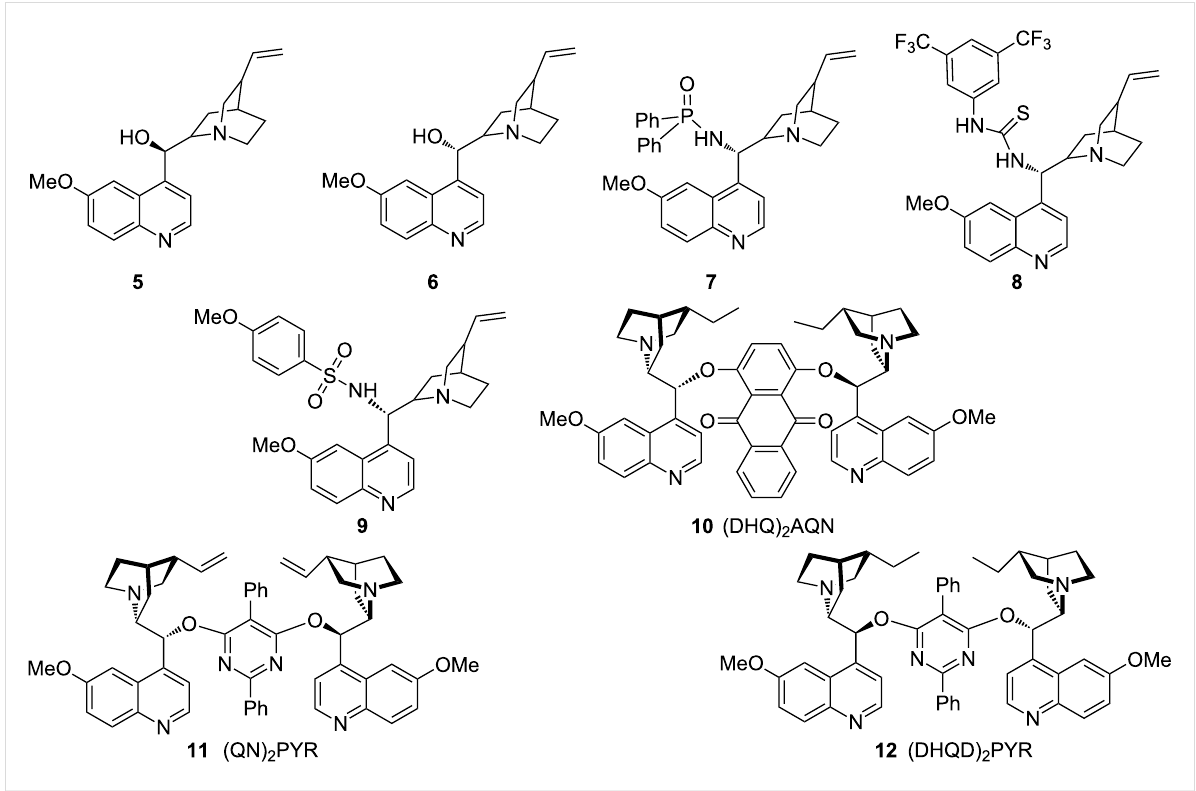
Figure 1: Cinchona alkaloid-derived catalysts screened for condition optimization (Table 1).